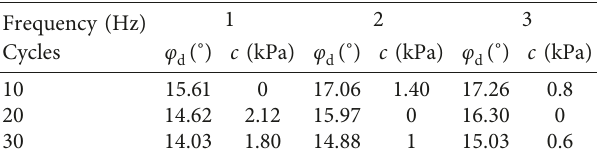
Figure 8: Mohr’s circle and strength envelope. Table 4: Dynamic strength indexes of saturated sand under dif- ferent cycles.